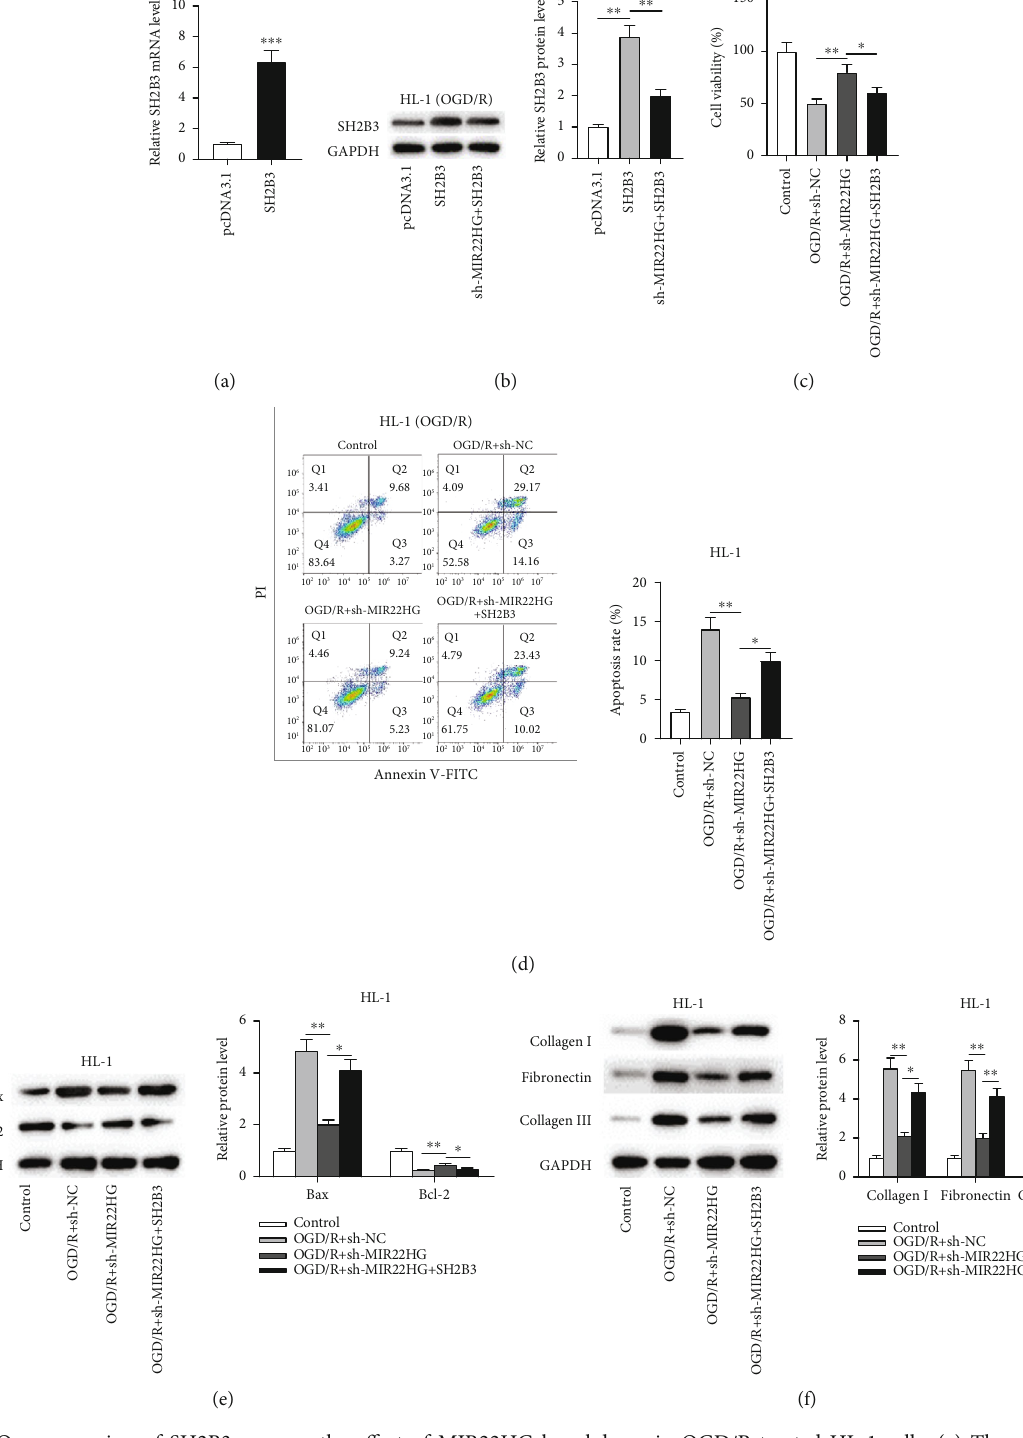
Figure 4: Overexpression of SH2B3 reverses the e ff ect of MIR22HG knockdown in OGD/R-treated HL-1 cells. (a) The overexpression e ffi ciency of pcDNA3.1/SH2B3 was tested by RT-qPCR ( n = 3 ). (b) The protein level of SH2B3 in each group was measured by western blotting ( n = 3 ). (c) The cell viability in di ff erent groups was detected by CCK-8 assay ( n = 3 ). (d) Cell apoptosis in di ff erent groups was assessed by fl ow cytometry ( n = 3 ). (e and f) The protein levels of Bax, Bcl-2, collagen I, fi bronectin, and collagen III in OGD/R-treated HL-1 cells transfected with di ff erent vectors were measured by western blotting ( n = 3 ). ∗ p < 0 : 05 , ∗∗ p < 0 : 01 , ∗∗∗ p < 0 : 001